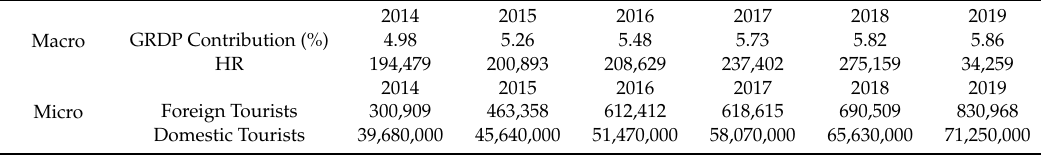
Table 1. Macro and Micro Conditions in the Tourism Sector in East Java in